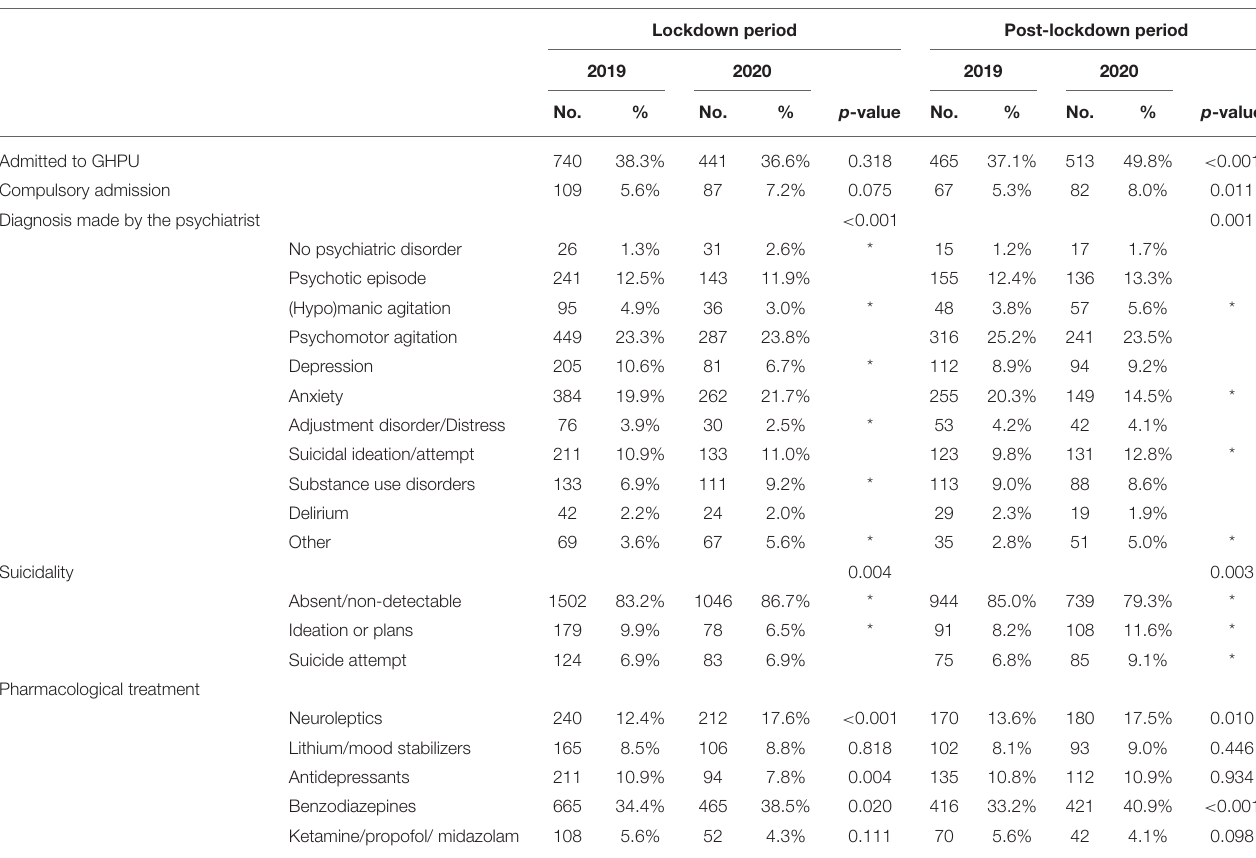
TABLE 3 | Characteristics of psychiatric consultations by period and